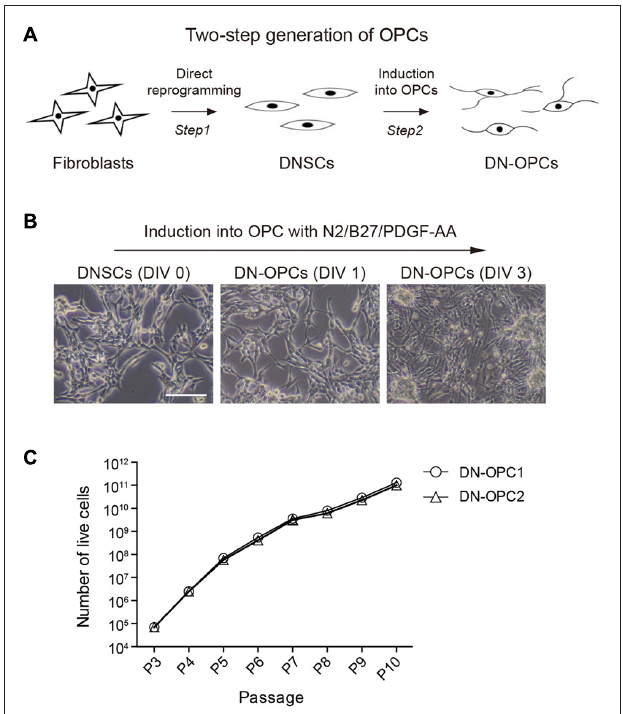
FIGURE 1 | Two-step generation of oligodendrocyte progenitor cells (OPCs) from neural stem cells (NSCs). (A) Diagram of experiment. The process of generating of direct conversion directly-induced neural stem cells (DNSCs) derived OPCs (DN-OPCs). (B) DNSC-derived OPCs Induction. DNSCs have a capacity of differentiation into OPCs. (C) Growth curves of DN-OPCs by the increase in passage. Data are present as the means ± SEM ( n = 3). Scale bar: 250 µ m.